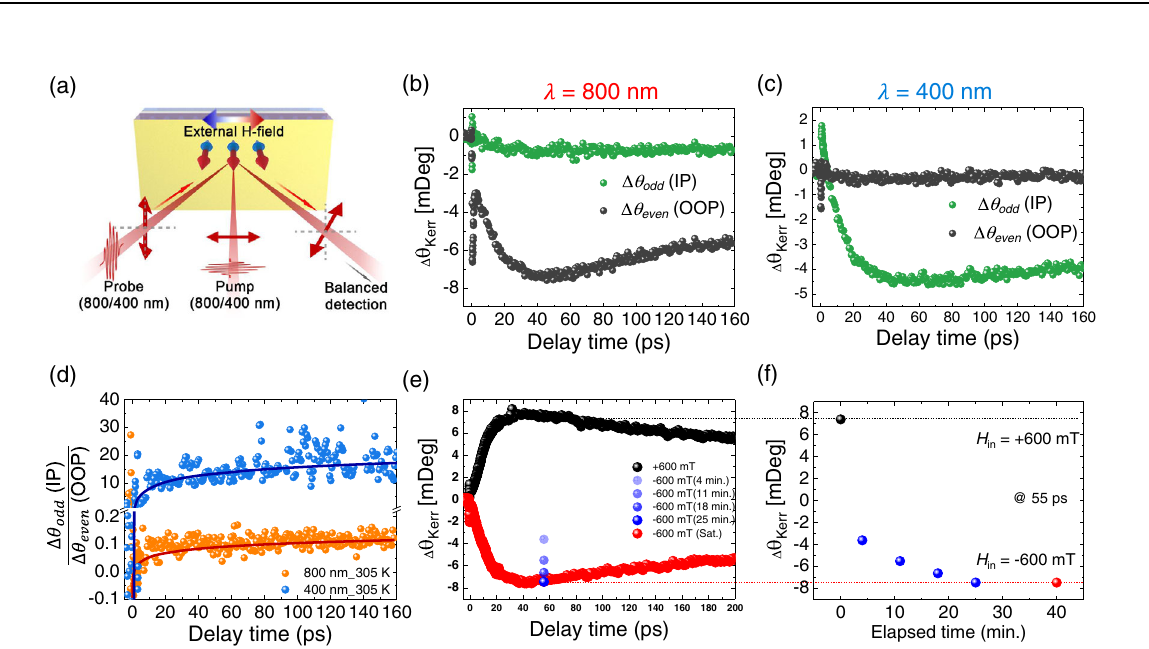
Fig. 2 | Hall and VSM measurement results. a , b Schematic of electrical Hall measurement for TbCo and Co. c , d Hall voltage as a function of OOP magnetic fi eld, H OOP , forTbCoand Co. e , f Hallvoltage asa function of IP magnetic